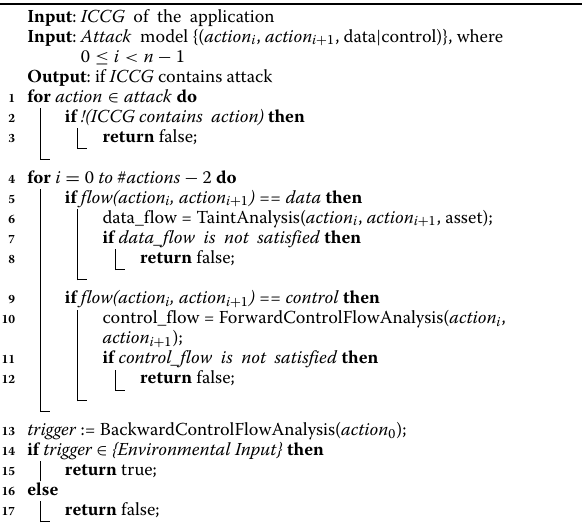
Algorithm 1: Model-based attack